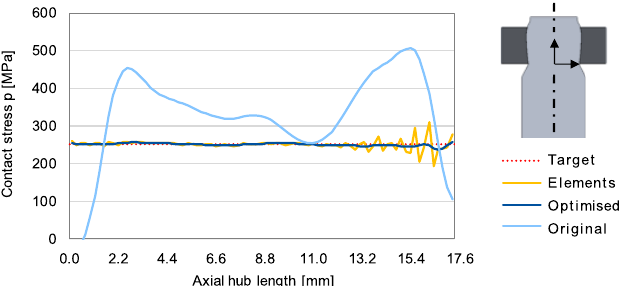
Fig. 6. Distribution of contact stress of initial straight hub and optimised concave hub contour.